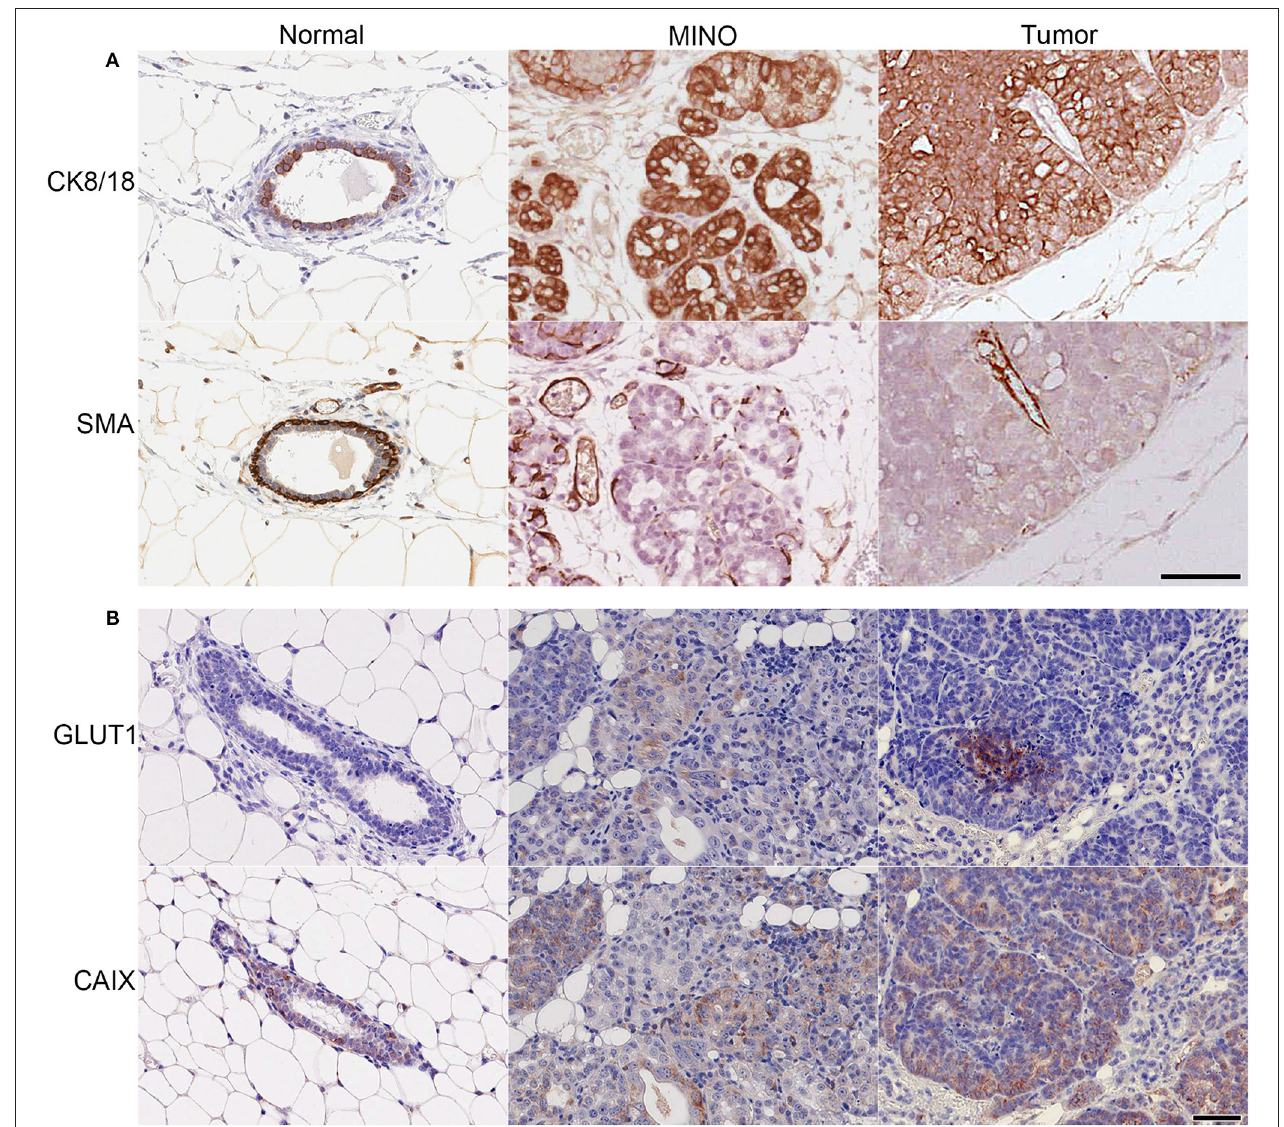
FIGURE 1 | MINO tumor cells originate from ductal (CK8/18 + ), not myoepithelial (SMA + ) cells and have high expression of GLUT1 and CAIX compared with normal mammary gland or MINO tissues. Immunohistochemical staining of normal, MINO, and MINO tumor tissue for (A) the structural proteins cytokeratin 8/18 (CK 8/18) and smooth muscle actin (SMA) and for (B) glucose uptake, glucose transporter 1 (GLUT1), and hypoxia, carbonic anhydrase 9 (CAIX). The scale bars on the lower right image in (A) and (B) are 50 µ m in length and are representative for each of the other images in the